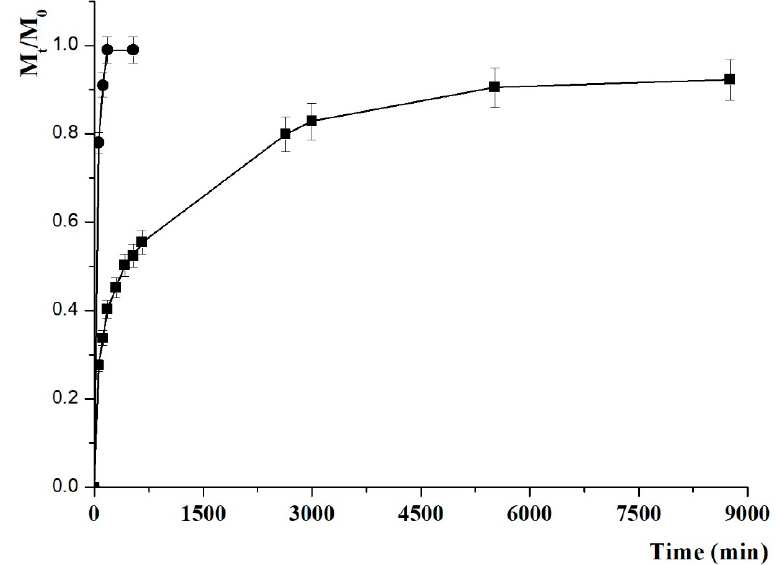
Figure 4. Release profiles of free ( ● ) and DC-loaded ( ■ ) MTX in PBS 0.01 mol L − 1 , pH 7.4.